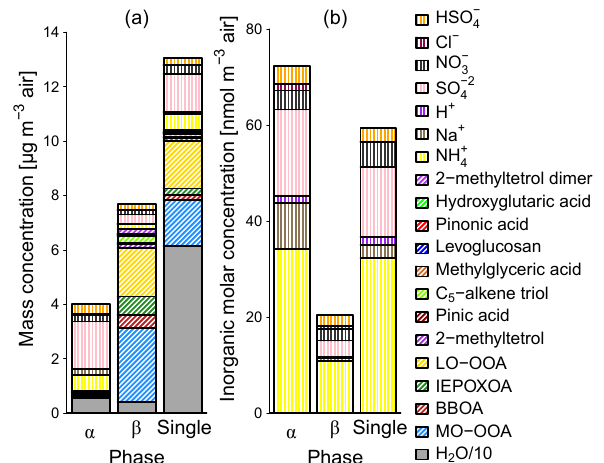
Figure 3. Average composition of the α (electrolyte rich), β (or- ganic rich), and single phase in terms of (a) mass (organic and inor- ganic components) and (b) moles (ions only) predicted by AIOM- FAC using PM 2 . 5 aerosol composition observed during SOAS. Species are stacked in the same order as indicated by the